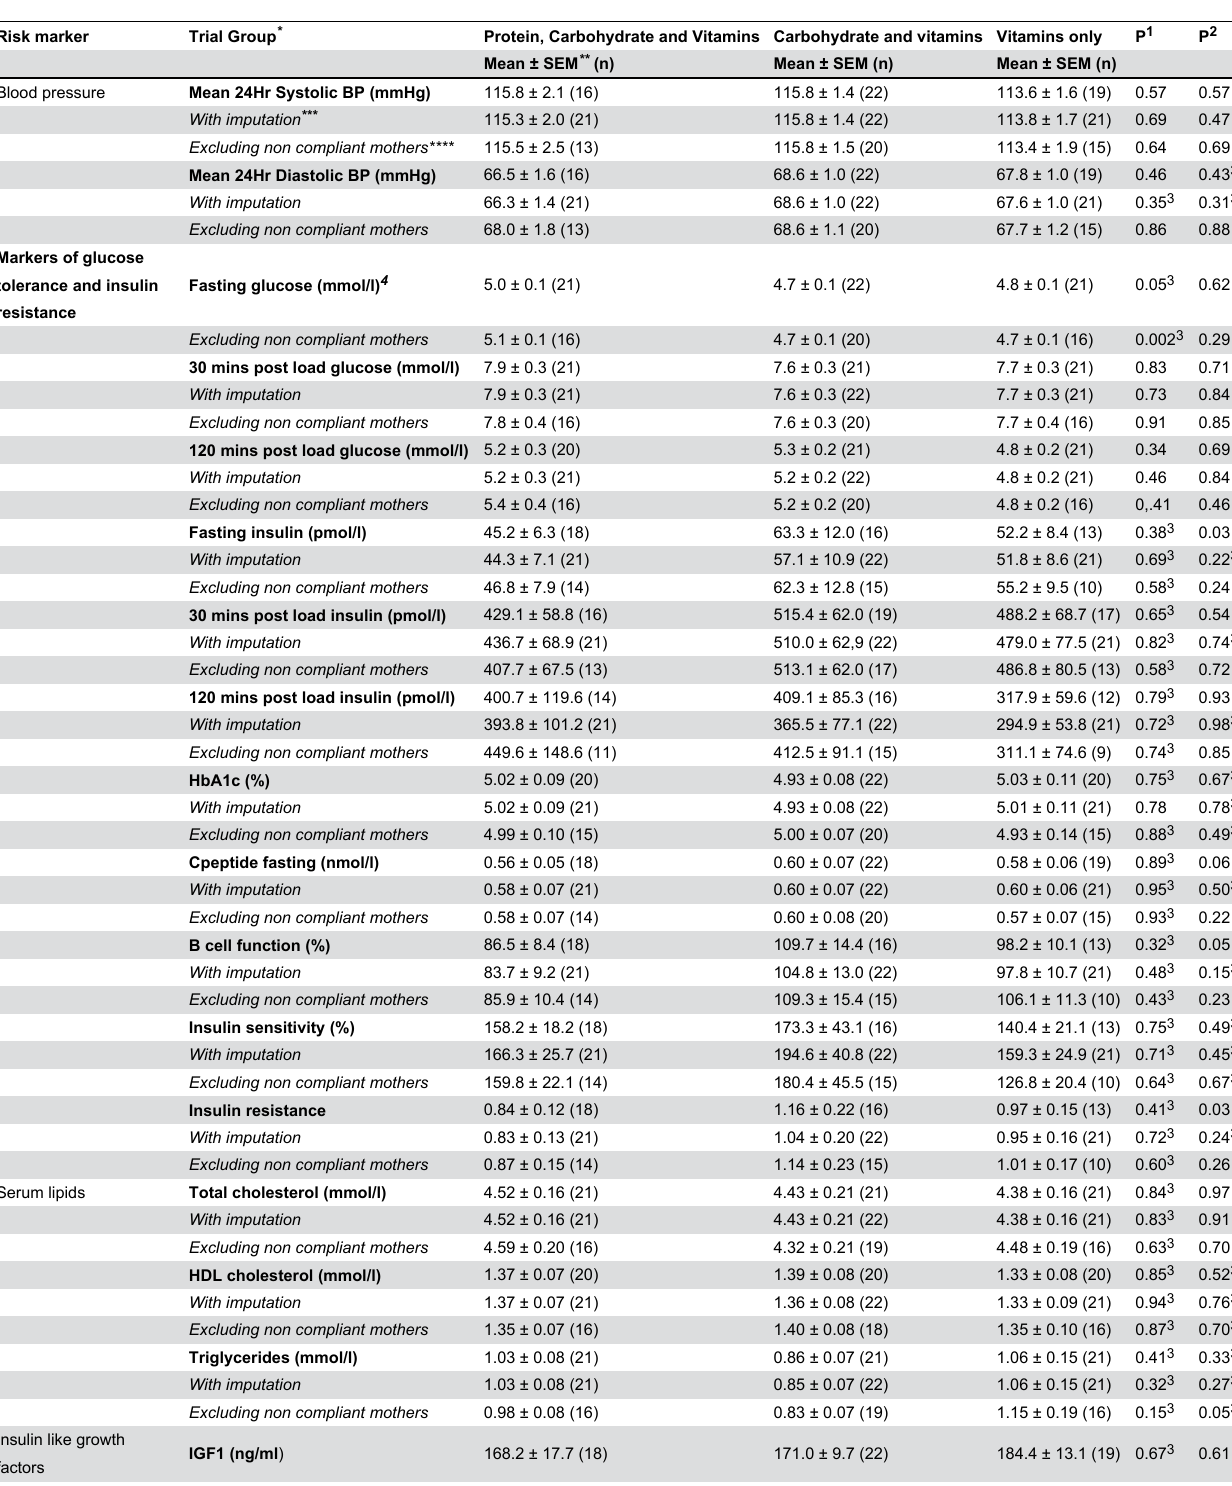
Table 3. Adult disease risk markers amongst offspring of mothers participating in the Sorrento studies of maternal nutritional supplementation who were assessed as adults before and after imputation of missing values - Trial I (supplementation in all mothers after 18